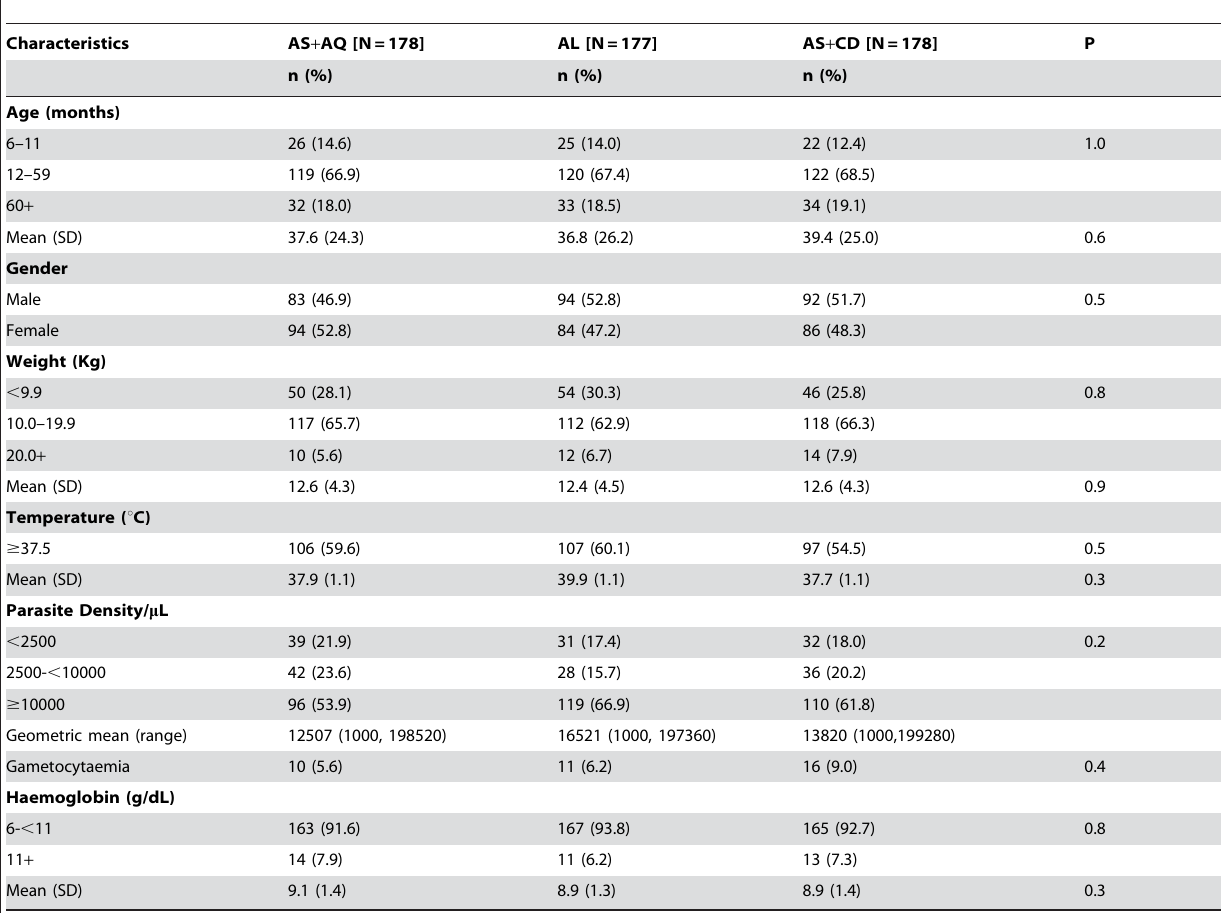
Table 1. Demographic and haematological characteristics at enrolment in G6PD normal children.